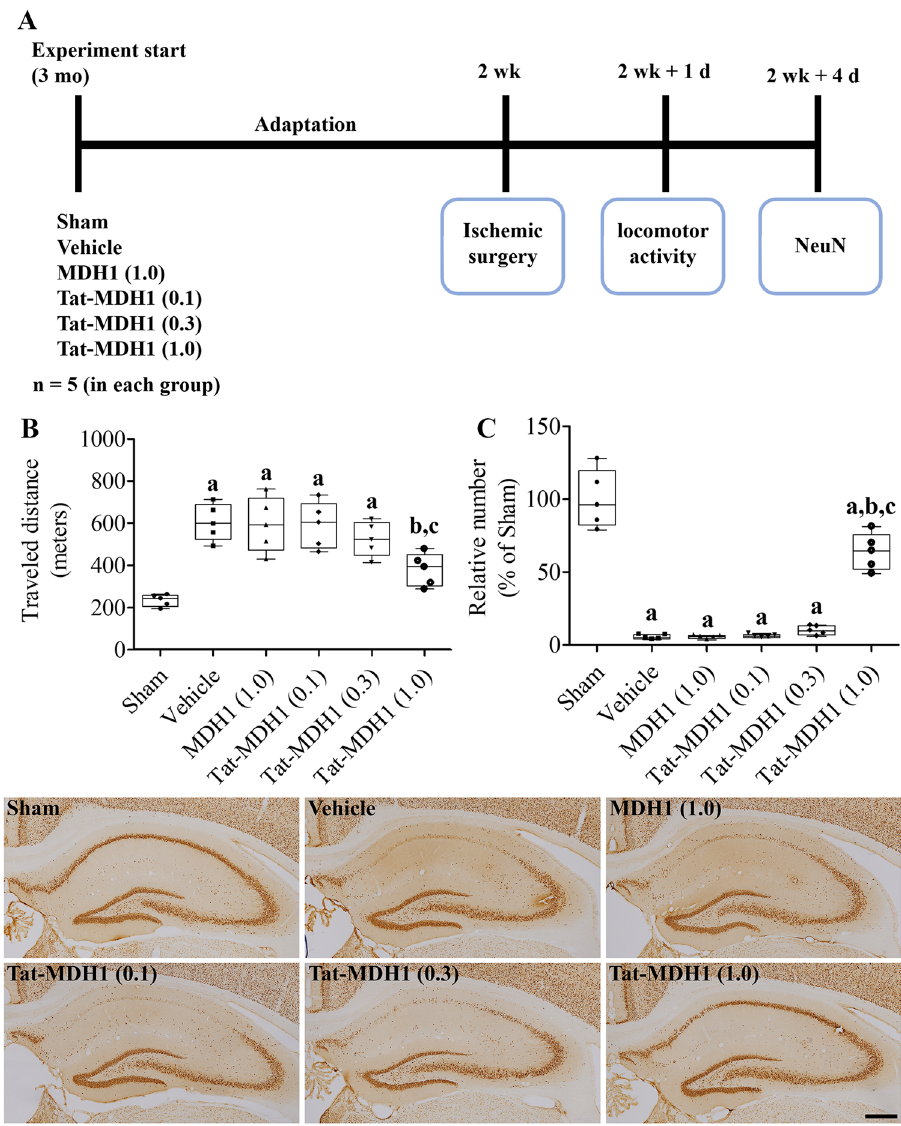
Figure 4. In vivo neuroprotective effects of Tat-MDH1 against 5 min of ischemic damage in gerbils. ( A ) Schematic drawing of the motor activity test and immunohistochemical staining for NeuN. ( B ) Locomotor activity was recorded and distance traveled was traced 1 d after ischemia in the sham-operated (sham), Tat peptide (vehicle)-treated, 1.0 mg/kg MDH1-treated [MDH1 (1.0)], and 0.1 mg/kg MDH1-treated [MDH1 (0.1)], 0.3 mg/kg MDH1-treated [MDH1 (0.3)], and 1.0 mg/kg Tat-MDH1-treated [Tat-MDH1 (1.0)] groups. ( C ) Surviving neurons 4 d after ischemia were visualized by immunohistochemical staining for NeuN in the hippocampus. Scale bar = 400 μm. The number of NeuN-immunoreactive neurons in CA1 region was counted, and the percentile number versus sham-operated group was demonstrated. Data were analyzed using one-way analysis of variance followed by Tukey’s multiple comparison post hoc test ( a p < 0.05, significantly different from the sham-operated group; b p < 0.05, significantly different from the vehicle-treated group; c p < 0.05, significantly different from the MDH1-treated group). Data are shown as mean + standard